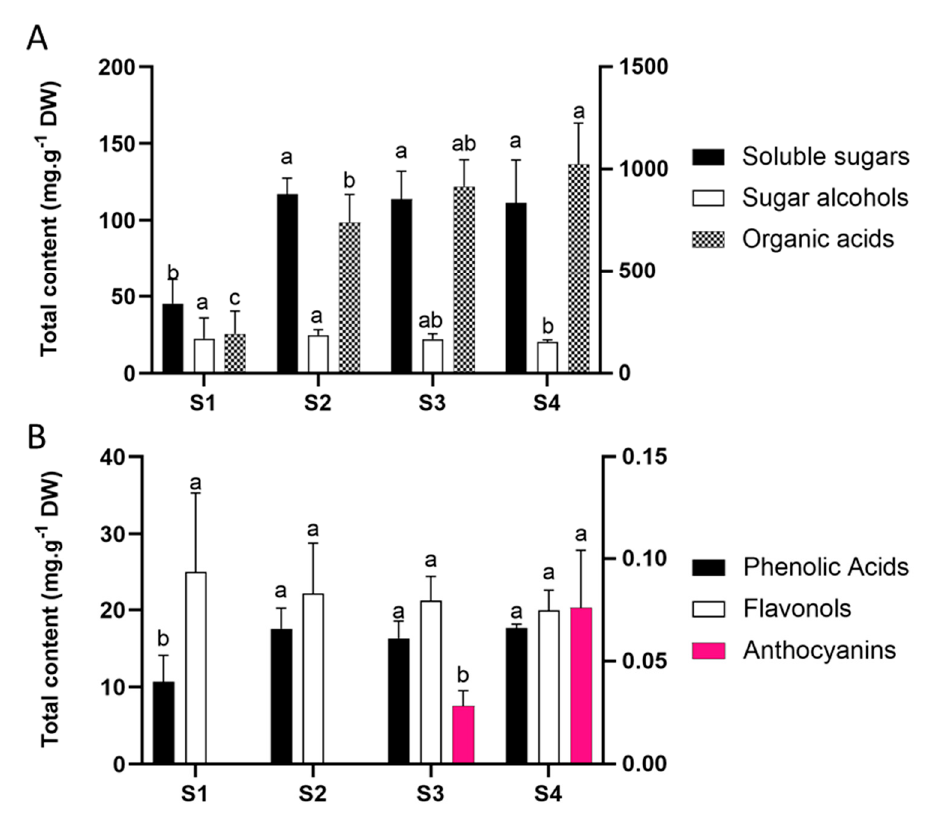
Figure 2. ( A ) Primary metabolites and ( B ) secondary metabolites during Pleroma raddianum flower development. The right scale represents soluble sugar content ( A ) and anthocyanins content ( B ). For each compound class, different letters indicate statistically significant differences ( p < 0.05) between stages. Bars indicate standard deviation. S1—buds (day 0), S2—white flowers (day 1), S3—pink (day 2), S4—purple (day 3), DW—dry weight.